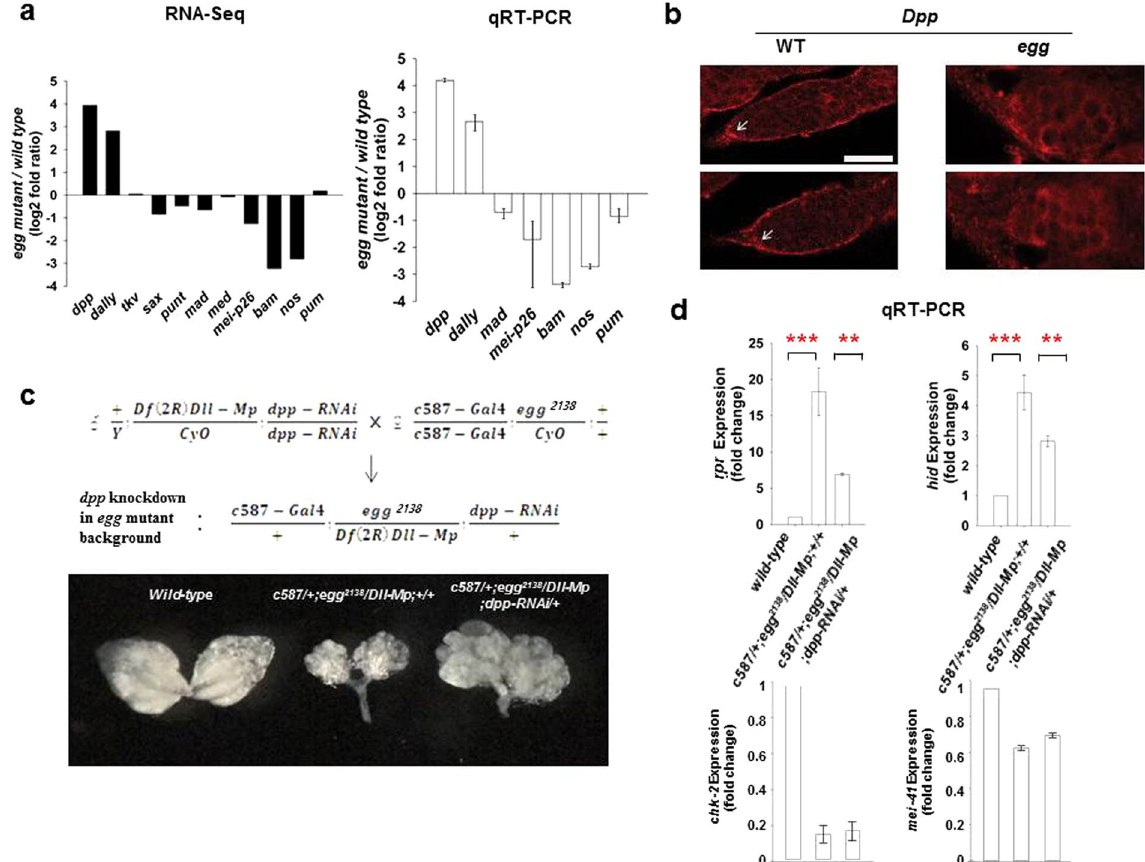
Figure 3. RNAi-mediated dpp knockdown in egg mutant germarium causes an increase in ovary size. ( a ) Representative expression profiles of genes involved in Dpp signaling. RNA-seq data analysis (black bar) revealed that expression levels of dpp and dally were upregulated whereas those of nos and mei-P26 were downregulated in egg mutant ovaries compared with wild-type ovaries. Consistent with dpp and dally upregulation, bam was downregulated. Expression levels of tkv , sax , punt , mad , med , and pum were not significantly changed. Fold changes are shown on the log 2 scale ( egg mutant/wild-type). qRT-PCR assays (white bar) of the expression of seven representative genes ( dpp , dally , mad , mei-P26 , bam , nos , and pum ) were performed at least three times. Fold changes are shown on the log 2 scale ( egg mutant/wild-type). Error bars represent standard deviation. ( b ) Germaria stained with anti-Dpp antibody. Dpp was detected specifically at the anterior tip (arrow) of wild-type germaria (left panels). Dpp appears increased and diffused from the anterior tip of egg mutant germaria (right panels). Scale bar represents 20 µ m. ( c ) Representative light microscopic image of ovaries. RNAi-mediated dpp knockdown in egg mutant germarium causes an increase in ovary size. Ovaries of egg mutants (middle) are severely reduced in size compared with wild-type ovaries (left). 15–20% (n = 630) of egg mutant ovaries also carrying c587-Gal4 and dpp-RNAi transgenes ( c587-Gal4 / + ; egg 2138 /Df(2R)Dll-Mp; dpp-RNAi / + , right) showed an increase in size compared to egg mutant ovaries ( c587-Gal4 / + ; egg 2138 /Df(2R) Dll-Mp; + / + , middle). ( d ) qRT-PCR assays. The increased expression levels of rpr and hid in egg mutant ovaries ( c587-Gal4 / + ; egg 2138 /Df(2R)Dll-Mp; + / + ) were significantly reduced in egg mutant ovaries also carrying c587-Gal4 and dpp-RNAi transgenes ( c587-Gal4 / + ; egg 2138 /Df(2R)Dll-Mp; dpp-RNAi / + ) (one-way ANOVA with Bonferroni; ** P < 0.01, *** P < 0.001; error bars represent standard deviation of three biological replicate experiments). RNAi-mediated dpp knockdown in egg mutant germarium did not change the expression levels of chk-2 and mei-41 in egg mutant